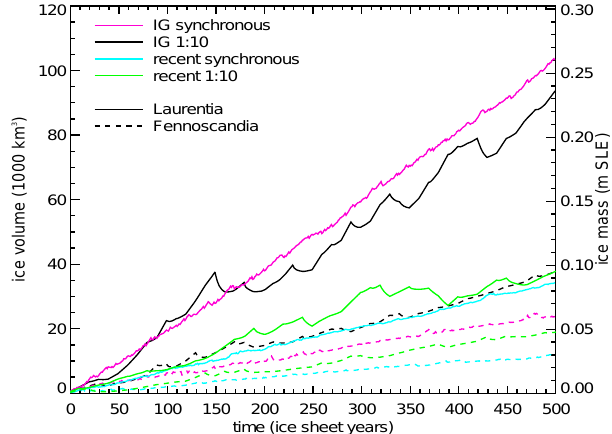
Fig. 3. Ice-sheet mass as a function of time for the first 500yr of the synchronous and asychronous (1 : 10) experiments. Glimmer do- mains are indicated by linestyle, and experiments by colour. Values are annual